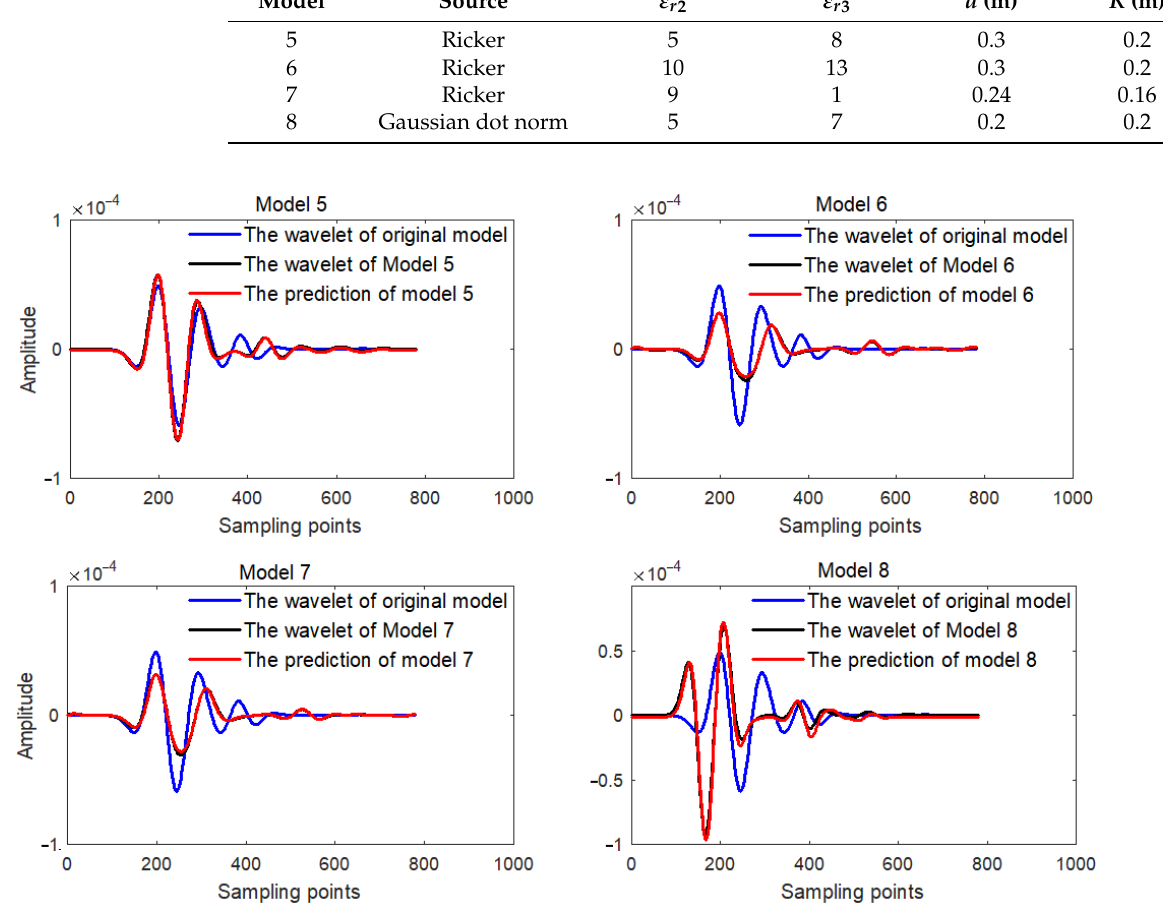
Figure 13. The predicted wavelet of derived models 5–8.